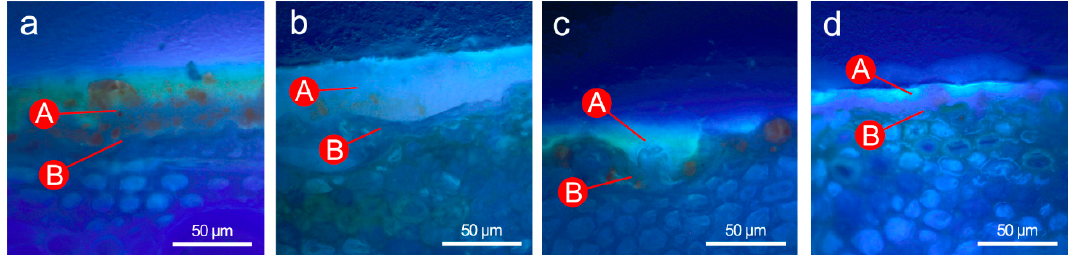
Figure 3. Cross sections observed through the optical microscope under UV illumination: P3 at ( a ) t = 0 h and ( b ) at t = 520 h; P8 at ( c ) t = 0 h and ( d ) at t = 520 h. The letter A indicates the outer OCV layer and B indicates the AC primer layer under the outer OCV coat.